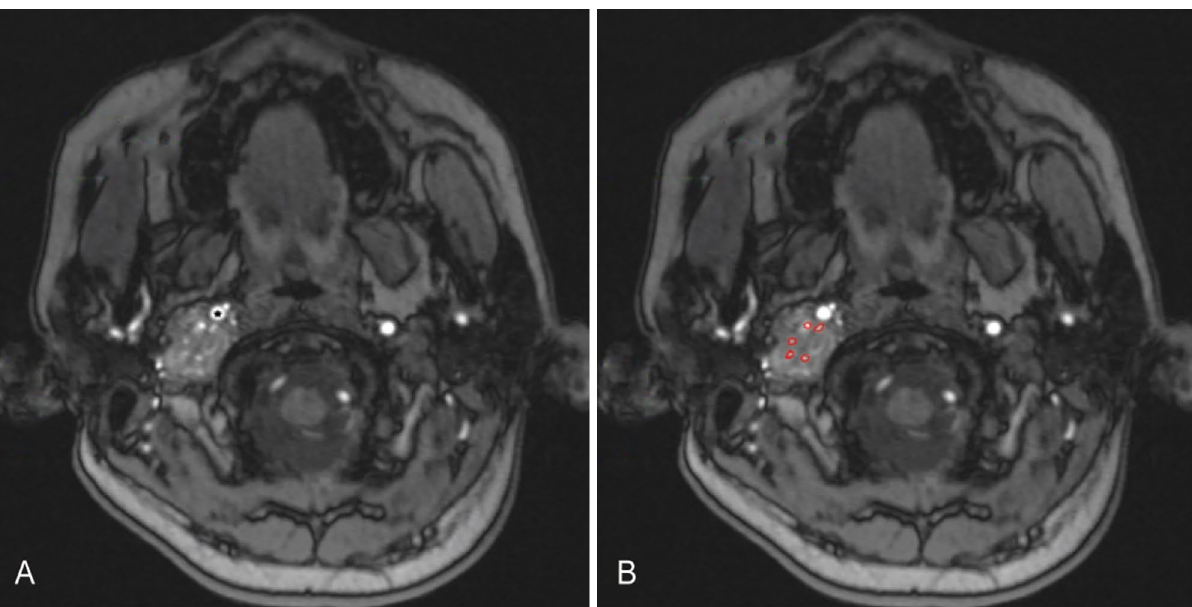
Figure 1. The preoperative axial MRA image of patient with C3 JPs on the right. There are multiple intratumor blood vessels and intraoperative blood loss was 600 ml. ( A ) The black star indicates the internal carotid artery. ( B ) The red areas represent the maximum cross-sectional area of intratumor blood